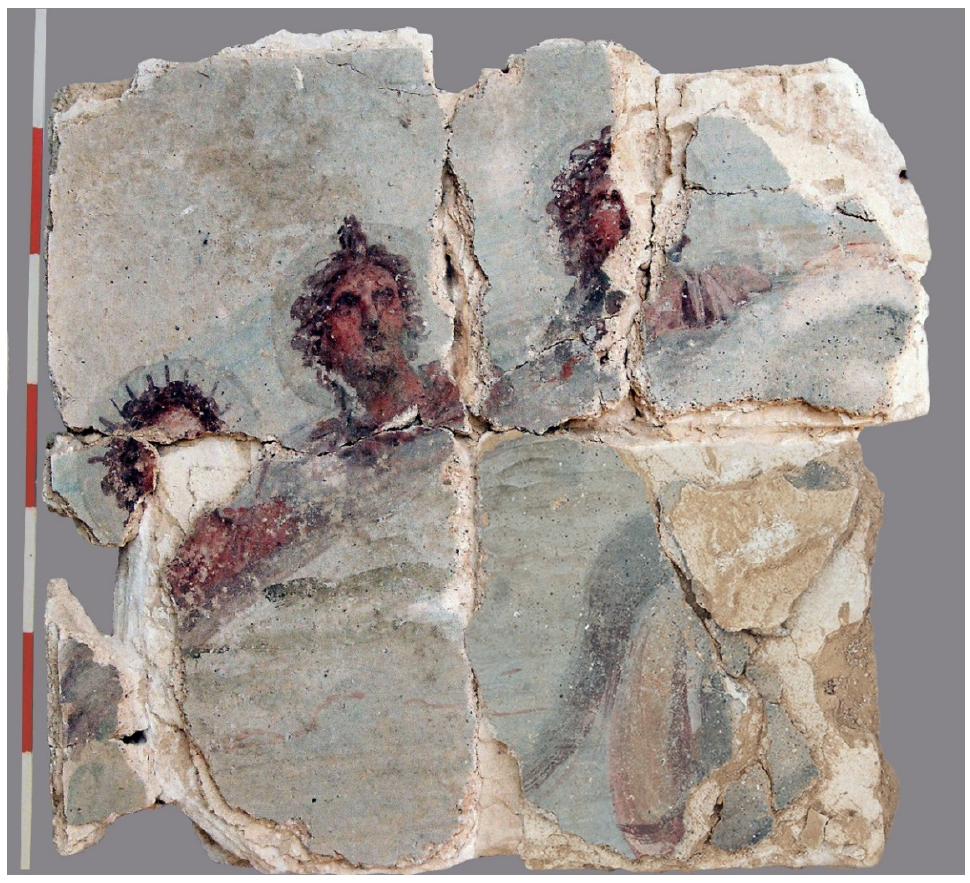
Figure 16. Painting depicting three gods: Helios, Harpocrates and Serapis, in the aedicula in the oikos of house H10 (photo Stanisław